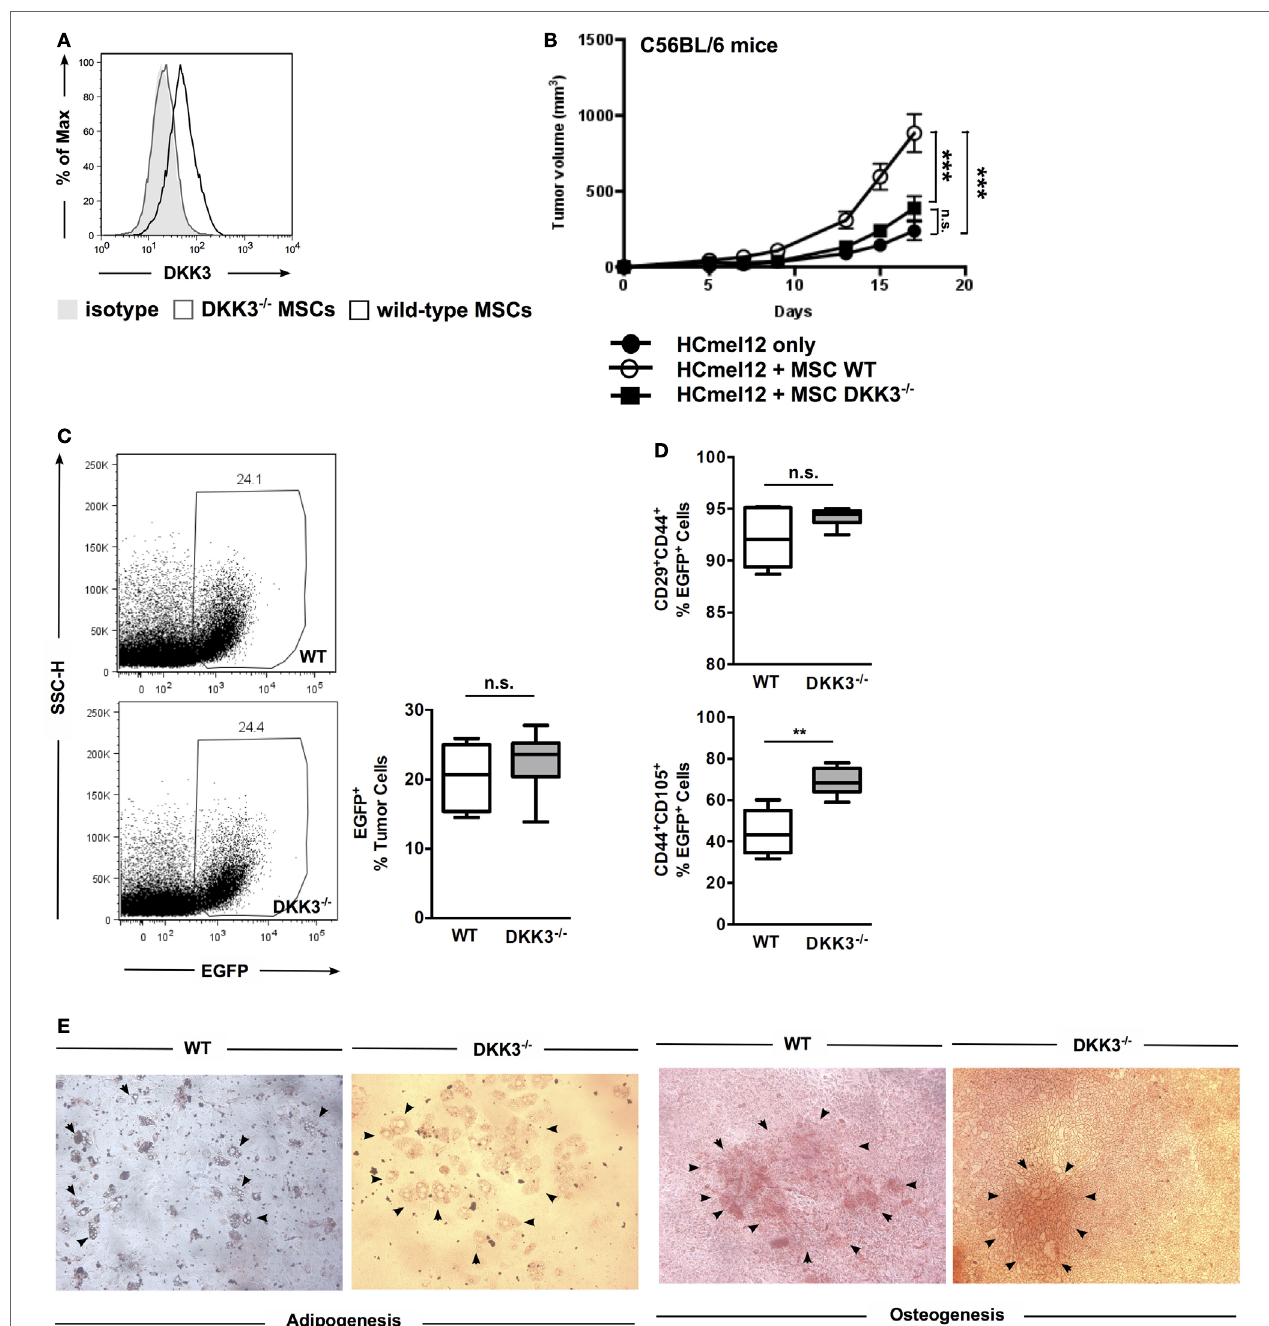
FigUre 1 | DKK3 expression by Mscs is essential for their suppressive activity of anti-tumor responses . (a) DKK3 expression was detected in wild-type mesenchymal stem cells by flow cytometry. (B) 4 × 10 5 HCmel12 cells with or without equal number of mesenchymal stem cells (MSCs) were inoculated subcutaneously into B6 mice. Better growth in size and speed was observed when tumor cells were inoculated together with DKK3-competent MSCs ( ⚬ , n = 13) in comparison with DKK3 − / − MSCs ( ⚫ , n = 13) or without any MSCs ( ◾ , n = 13) ( p < 0.0001 or p < 0.0001). No difference was observed between the growth of tumor with DKK3 − / − MSCs and without any MSC ( p = 0.1175). Two independent experiments were performed. ANOVA followed by the Holm-Šídák approach to multiple comparisons was applied. (c) 4 × 10 5 EGFP-positive wild-type MSCs ( n = 7) or DKK3 − / − MSCs ( n = 7) were subcutaneously inoculated together with equal number of HCmel12 cells into B6 mice. Fourteen days later, there was no difference in the percentage of wild-type and DKK3 − / − EGFP + cells recovered from the HCmel12 tumor nodules ( p = 0.1309). (D) When identifying tumor-associated MSCs with mesenchymal stem cell marker in HCmel12 tumor, no change was observed on CD29 + CD44 + population ( p = 0.1053). However, CD44 + CD105 + cells were significantly increased in DKK3 − / − MSCs ( p = 0.0014). Two independent experiments were performed. Unpaired t -test was applied between two groups. (e) In vitro differentiation showed that DKK3 − / − MSCs maintained competent differentiation capacity as their wild-type counter part in adipogenesis and osteogenesis. The solid arrows indicate adipocytes or calcified